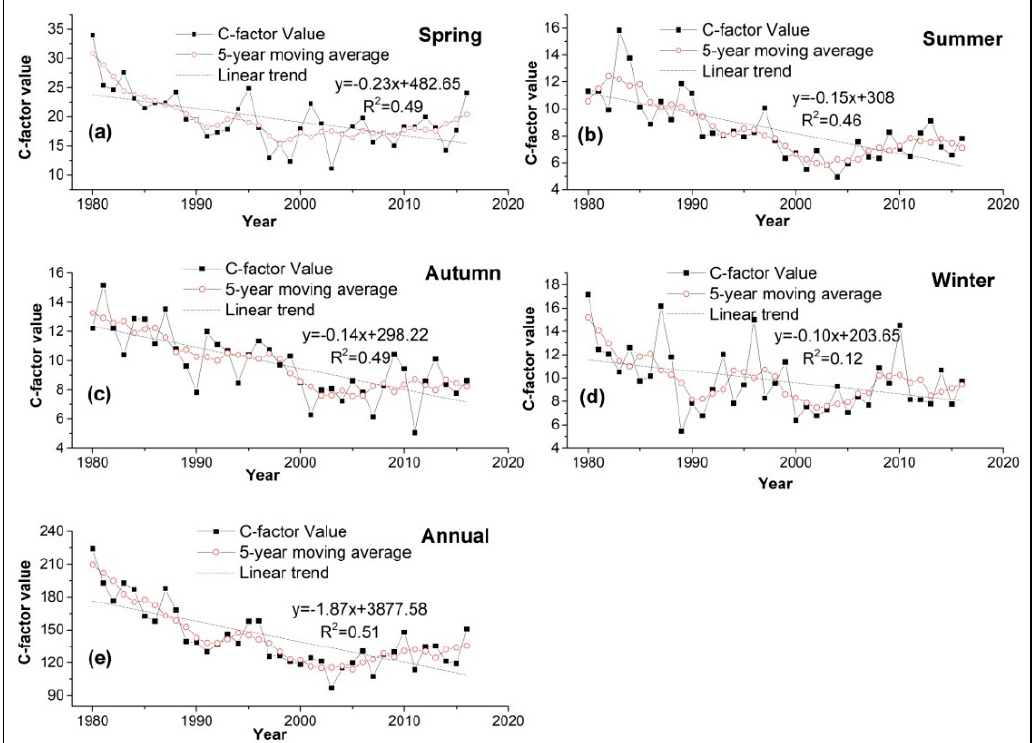
Figure 4. Trend charts of C-factor value in ( a – d ) seasonal and ( e ) annual scales from 1980 to 2016. Table 1. Variation trends of the C-factor value of weather